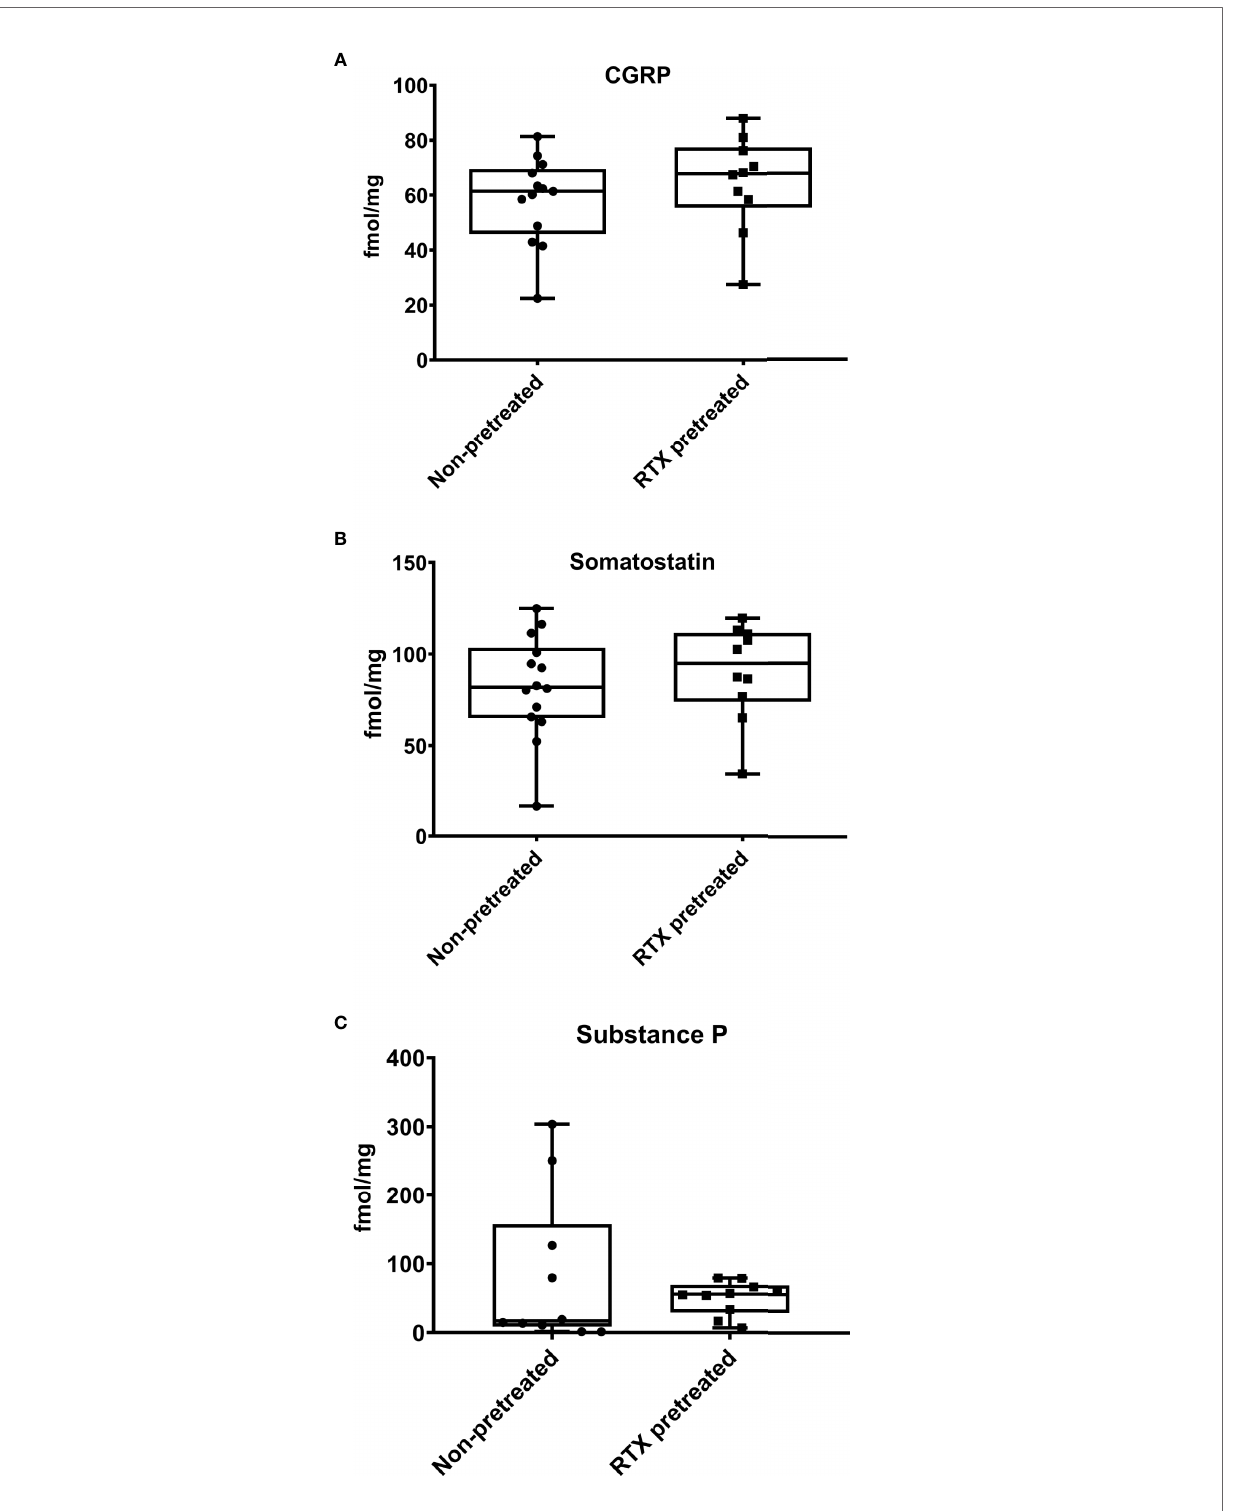
FIGURE 5 | Intratumoral concentrations of the neuropeptides Calcitonin Gene-Related Peptide (CGRP), Somatostatin, and Substance P (SP) measured by radioimmunoassay are not signi fi cantly altered by RTX-pretreatment. Intratumoral neuropeptide concentrations (fmol/mg) of (A) CGRP, (B) Somatostatin, (C) SP. The min to max values are demonstrated with all data